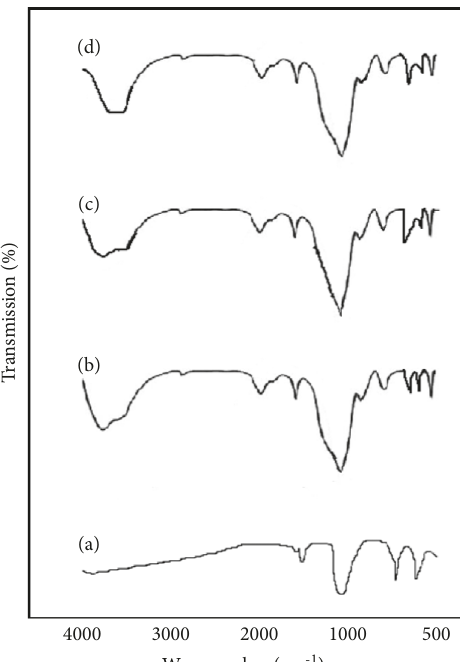
Figure 4: (a) Results for FTIR for stone without silica nanoparticles, (b) stone containing 0.5% silica nanoparticles, (c) stone containing 1% silica nanoparticles, and (d) stone containing 2% silica